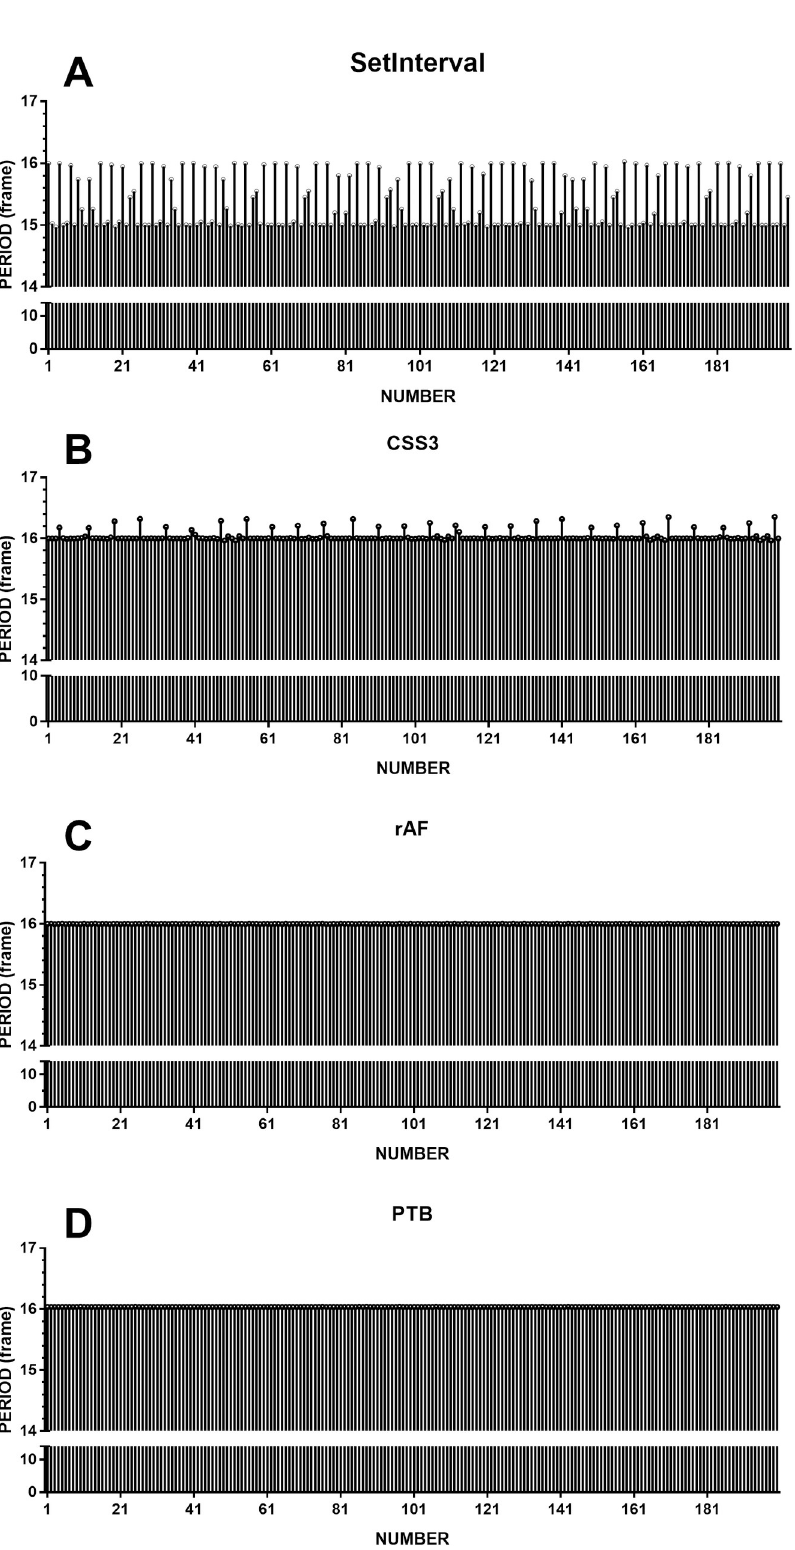
Fig 1. The time distribution of 200 sampling periods of dynamic sinusoidal gratings using different methods. A: the 200 periods produced by setInterval were randomly distributed between 14.9 frames and 16.1 frames; 150 frame losses occurred. B: the 200 periods produced by CSS3 were randomly distributed between 15.9 frames and 16.4 frames;